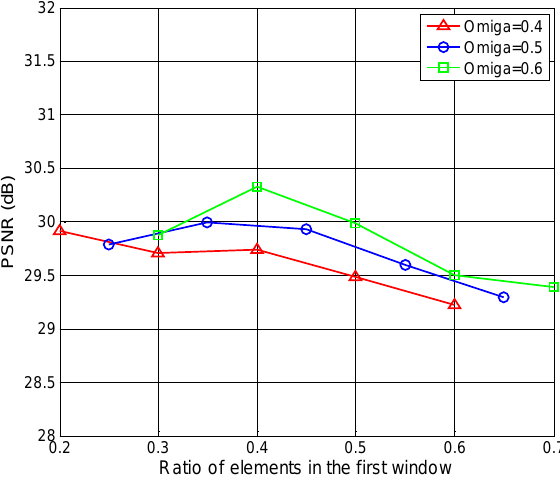
Figure 10. The PSNR performance with different first window size.